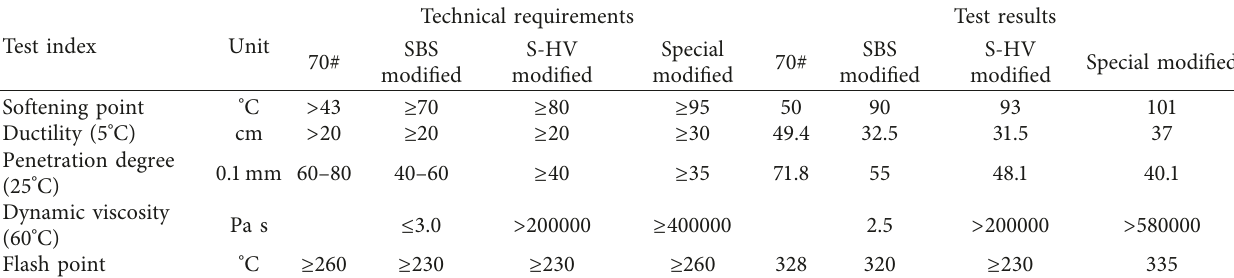
Table 1: Asphalt performance.